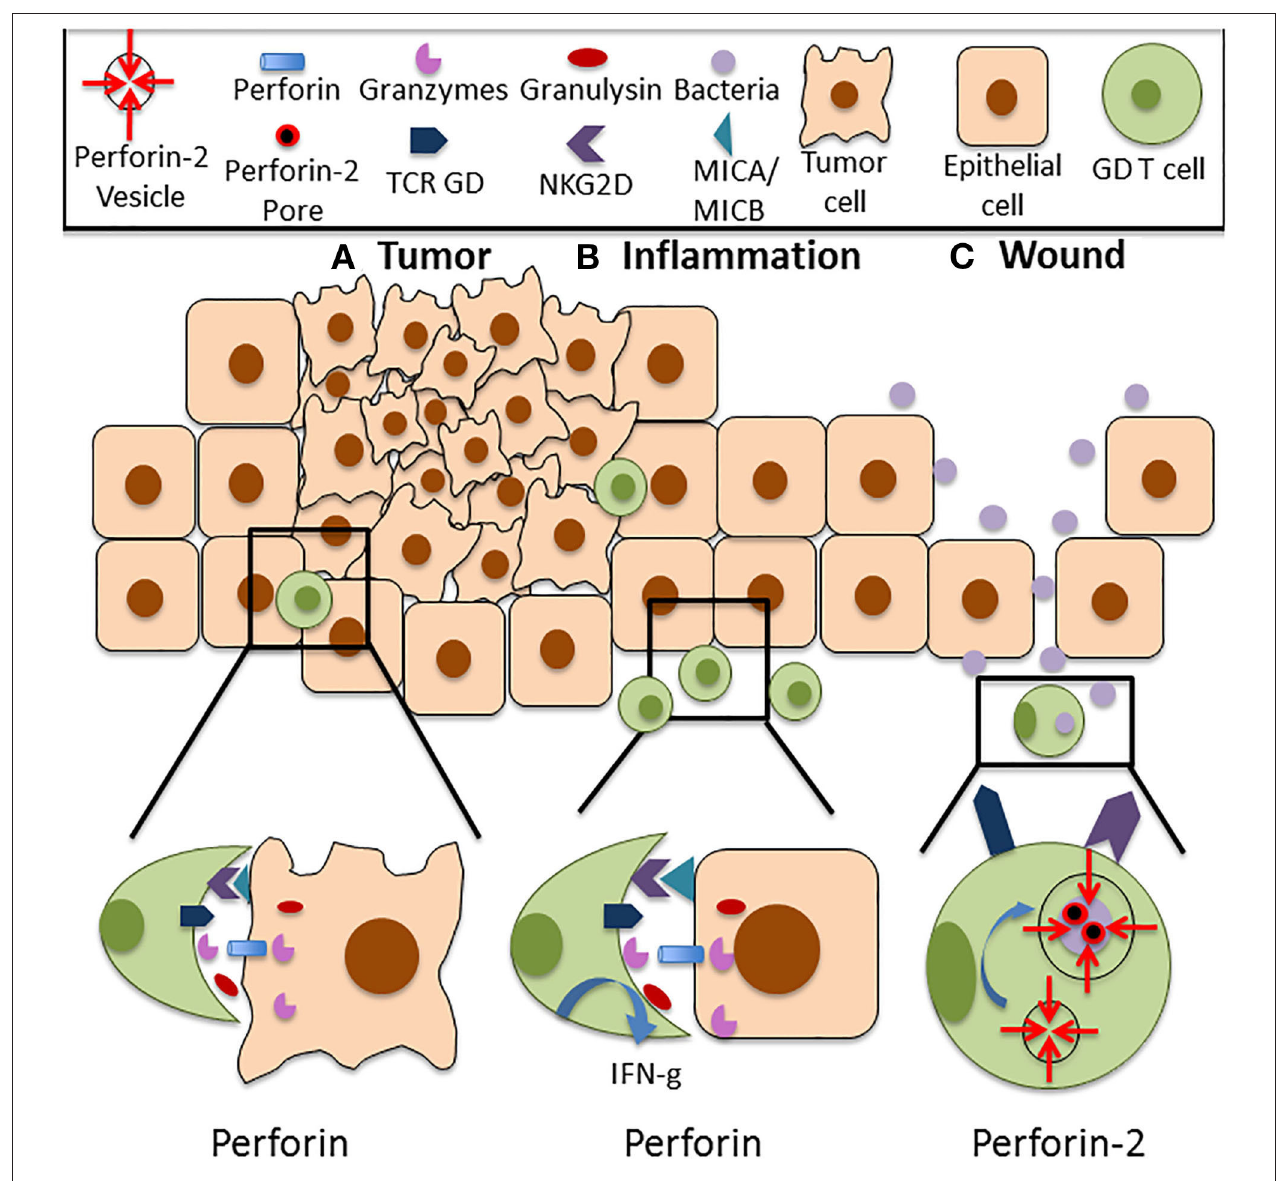
FIGURE 1 | Functions of Perforin in cutaneous GD T cells. (A) Cutaneous GD T cells exhibit cytotoxicity against an array of tumor cell types, and this is associated with Perforin expression both at the mRNA and protein level. Perforin is located within cytolytic granules inside cytotoxic GD T cells and they are released upon degranulation into the immune synapse. Perforin binds to the plasma membrane of the target cell and forms pores in the cell membrane, allowing granzymes, granulysin, and reactive oxygen species to enter the cell and destroy it. Cytotoxic GD T cells can become activated through TCR stimulation or through ligation of several costimulatory surface molecules, particularly NKG2D. NKG2D recognizes the stress induced ligands MICA and MICB, and NKG2D signaling is sufficient for activation of skin GD T cell cytotoxicity. (B) Perforin expressing GD T cells are also implicated in autoimmune and inflammatory skin diseases. Increased percentages of GD T cells have been observed in the skin of patients with systemic sclerosis, pemphigus vulgaris, Behcet’s disease, and psoriasis. These cells express Perforin and granzymes and demonstrate enhanced cytotoxicity in comparison to cells from healthy controls. They also exhibit increased IFN-g expression. (C) Cutaneous GD T cells also express the newly discovered innate immune protein Perforin-2. Unlike other MACPF pore formers, Perforin-2 localizes to endosomes that fuse with the phagosome upon intracellular bacterial infection, facilitating pore formation on the bacterial cell membrane. Perforin-2 is essential for the elimination of intracellular bacteria. Given the established role of GD T cells in the antimicrobial response, it is likely that damage to the skin barrier and bacterial entry into the skin contribute to Perforin-2 induction in these immune surveillance cells.